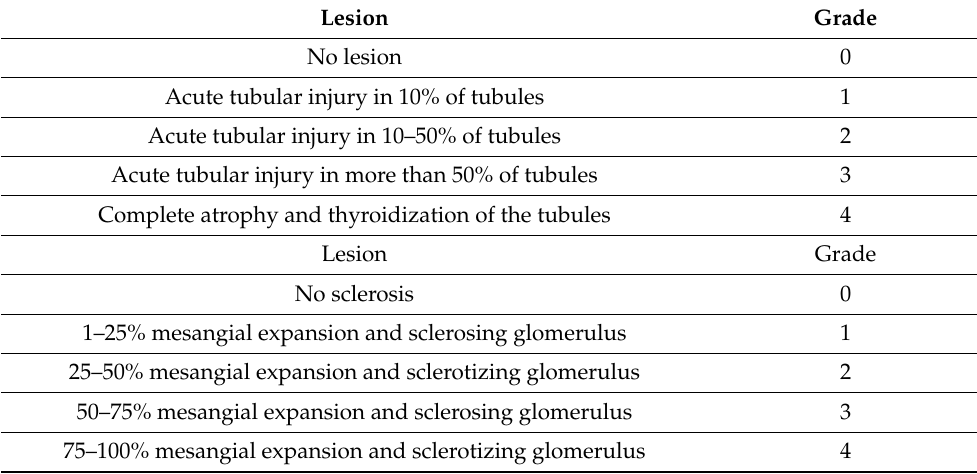
Table 4. Scoring features for renal tubular and glomerular damage. Lesion Grade No lesion 0 Acute tubular injury in 10% of tubules 1 Acute tubular injury in 10–50% of tubules 2 Acute tubular injury in more than 50% of tubules 3 Complete atrophy and thyroidization of the tubules 4 Lesion Grade No sclerosis 0